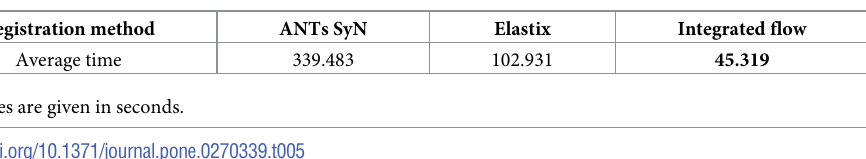
Table 5. Average execution time for three registration methods, the integrated flow (our method), ANTs SyN and